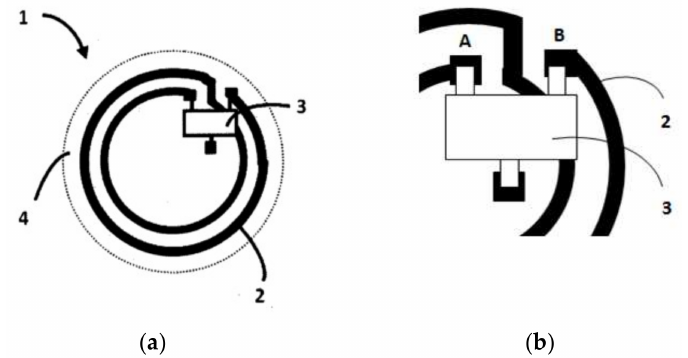
Figure4. Theinductivecouplingloopwithspiralgeometry: ( a )Generalview;( b )detailofelectricconnections.